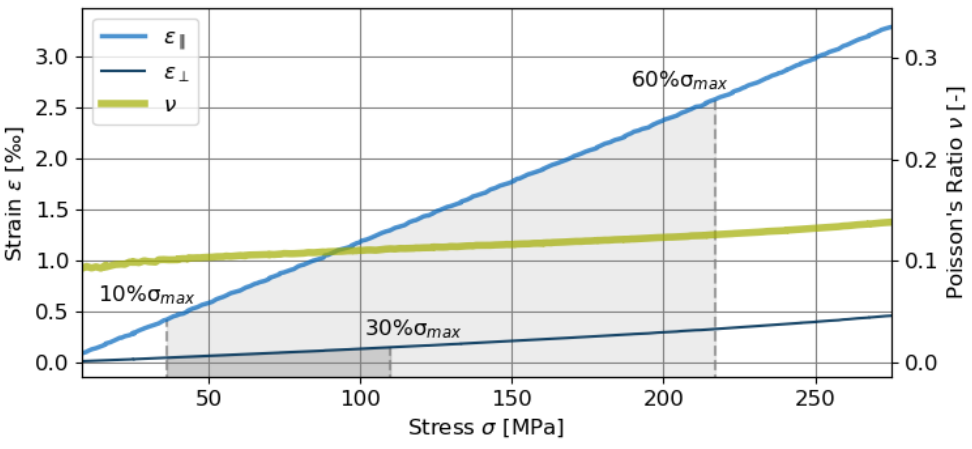
Figure 2. Stress–strain diagrams for longitudinal strain ε (cid:107) and lateral strain ε ⊥ obtained from uniaxial compression tests on a cylindrical quartzitic specimen. The strain gauges failed before reaching the ultimate compressive strength of 368.0 MPa. The plot also shows the Poisson’s ratio obtained from the ratio of the lateral and the longitudinal